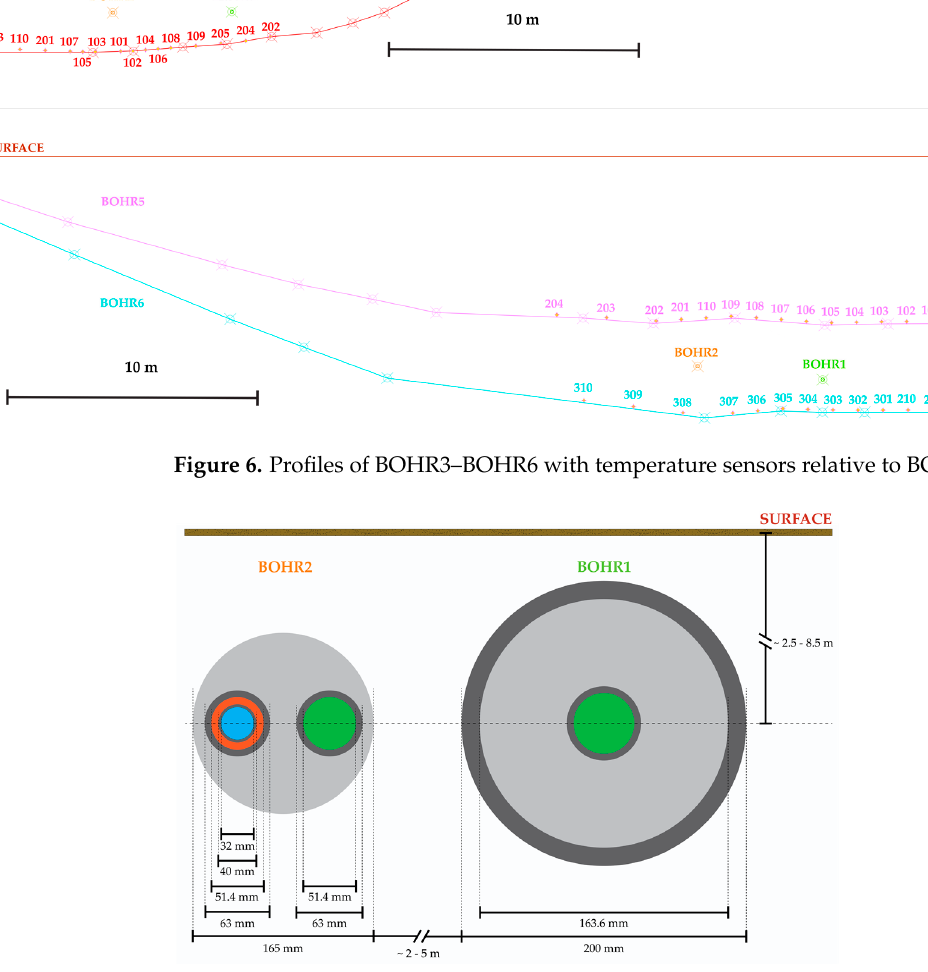
Figure 7. Cross–section of boreholes of BOHR1 and BOHR2 with internal piping. BOHR1 and BOHR2 each had 30 PT100 DIN1/3 temperature sensors installed (green pipes) and spaced ~3.7 m to ~5 m apart. Orthogonal measurement boreholes (BOHR3– BOHR6) each had 15 PT100 DIN1/3 temperature sensors installed (blue, red, pink, cyan lines in Figures 4–6) and spaced ~0.5 to ~2 m apart. Vertical boreholes were drilled to obtain soil samples to analyze properties of the soil, with three of them being used as measurement conduits (KERN1–KERN3) marked with a gold circle and crosshairs ( ). Each of the three vertical boreholes used for measurement had 8 temperature sensors spaced ~1 and ~1.5 m apart. All temperature sensors were recorded with an Agilent 34410A/11A multimeter. The material properties of components used in the construction of the heated borehole and measurement network are listed in Table 3. Table 3. Material properties of equipment used for the experimental set-up.